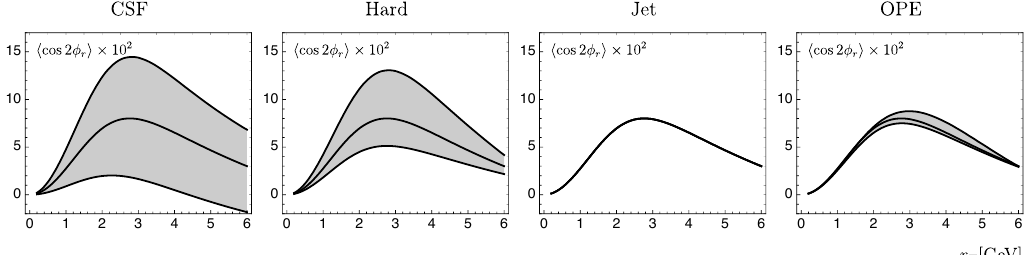
Figure 6. Angular modulation contribution for dijet production at EIC with error-bands coming from scale dependence in collinear-soft factor (CSF), hard factor (Hard), jet distributions (Jet) and √ Wilson coefficients (OPE). s = 140 GeV, R = 0 . 7 , p T = 20 GeV, η 1 = η 2 = 0 .